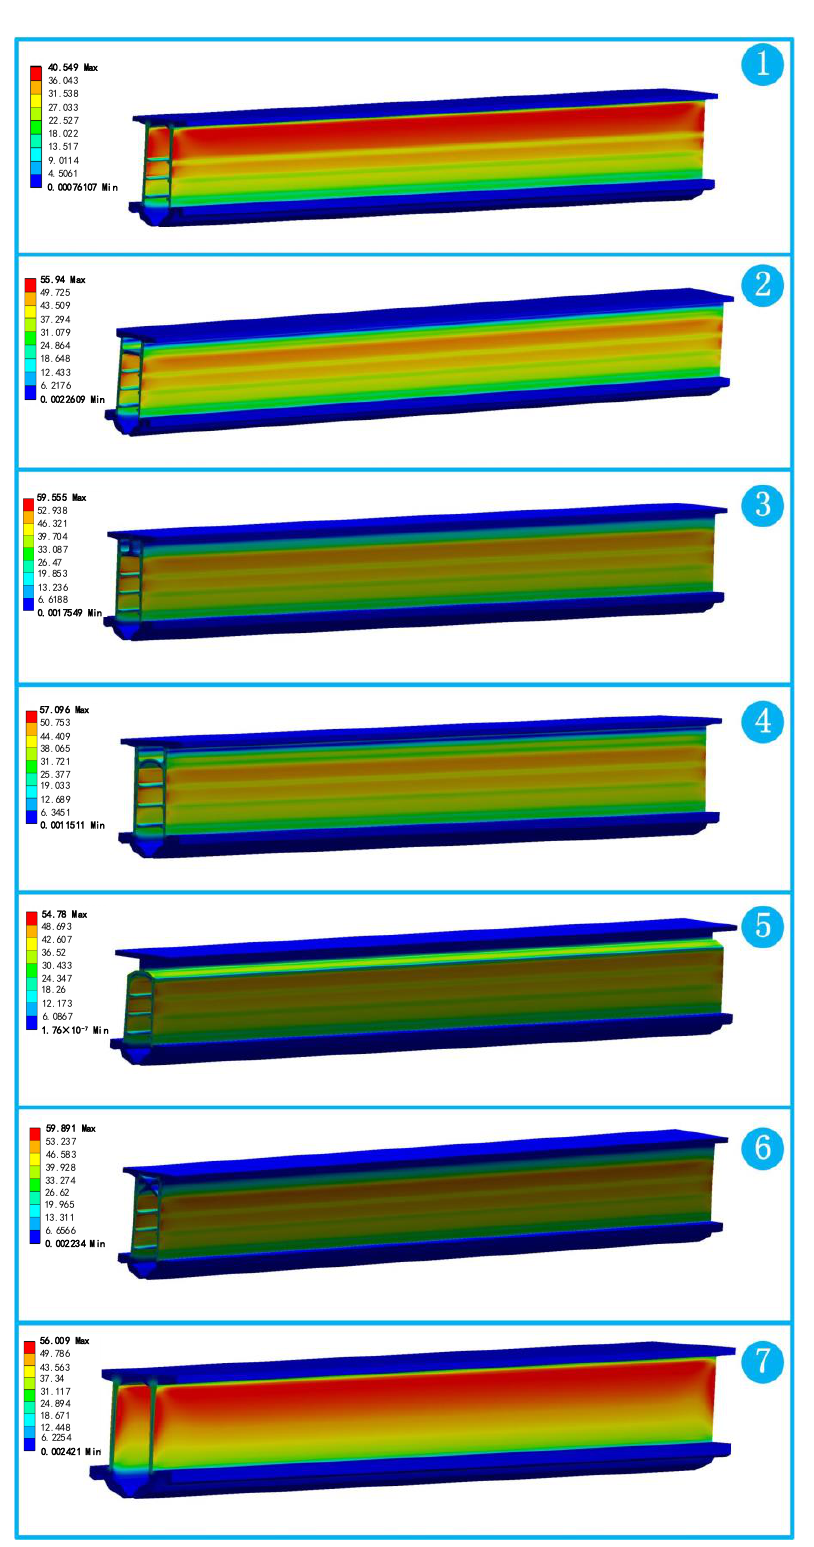
Figure 9. Stress distribution on conductor rail. No. 1 – 6 denote the results of new types of conductor rail with large moment of inertia, and the result of the conventional one is denoted as No. 7.